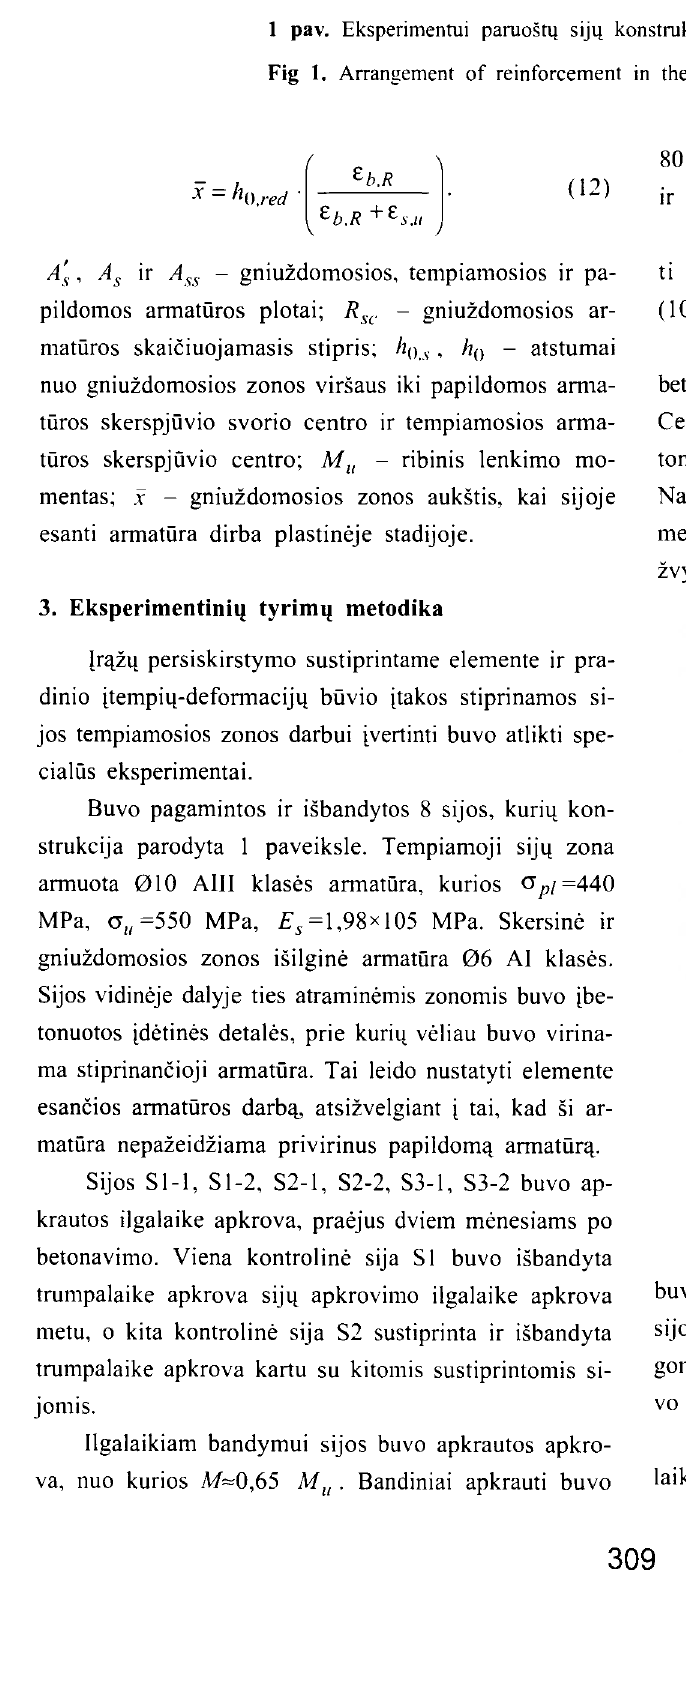
Fig 1. Arrangement of reinforcement in the beams investigated